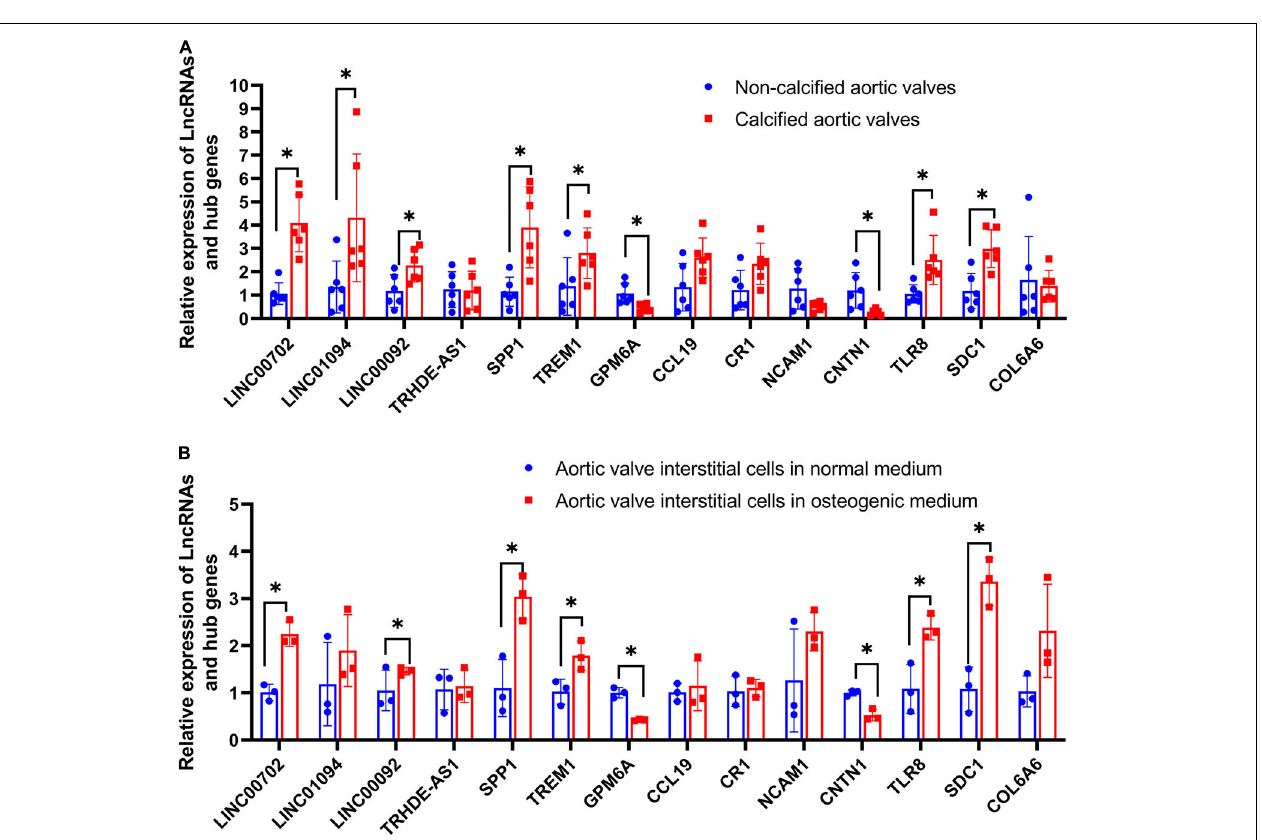
FIGURE 8 | Validation of four LncRNAs and hub genes. (A) The relative expression of LncRNAs and hub genes in clinical samples; (B) The relative expression of LncRNAs and hub genes in aortic valve interstitial cells. ∗ P < 0.05.